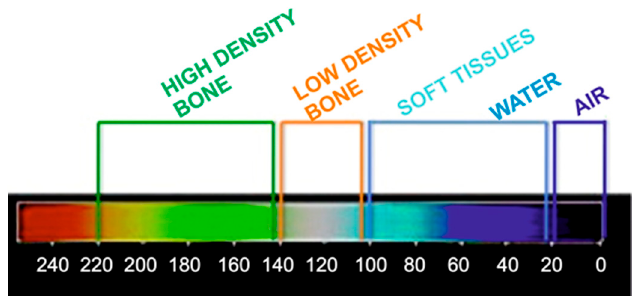
Figure 7. Color-graduated density scale for thermal imaging interpretations.